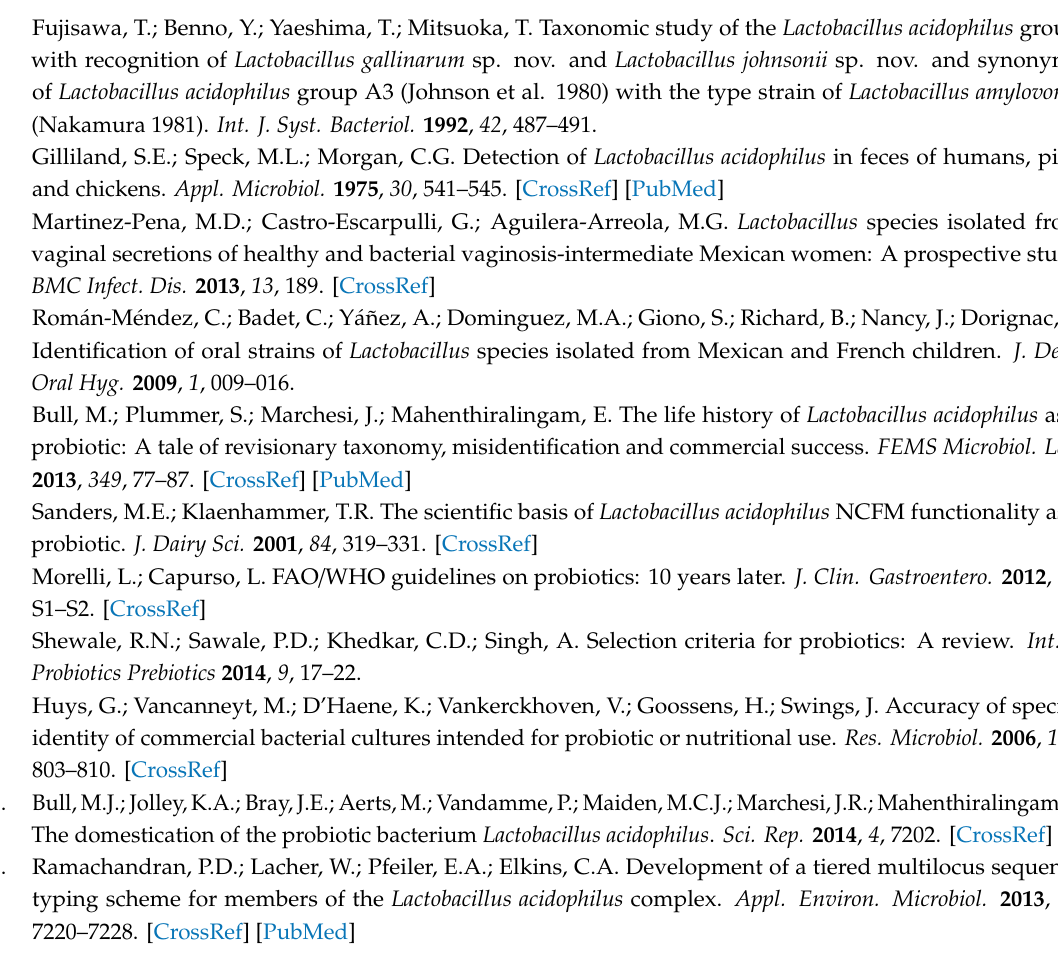
Figure S1: Unweighted pair group method with arithmetic mean (UPGMA) dendrogram based on OrthoANI values among the 41 Lactobacillus acidophilus strains. Figure S2: Alignment of Rex2 gene sequences among the 11 Lactobacillus acidophilus strains reference strains and LA1063, di ff ers in a 68-bp insertion / deletion. Figure S3: Discriminated loci between Lactobacillus acidophilus LA1063 and BCRC 17481. Table S1: Genomic characteristics of Lactobacillus acidophilus strains. Table S2. Genes and primers used for validation of reference strains. Table S3. List of the 1390 cgMLST loci in 41 Lactobacillus acidophilus